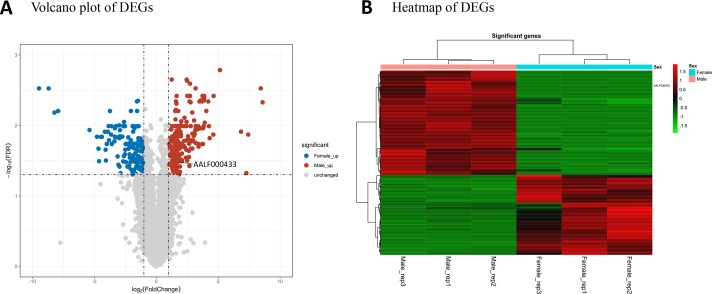
mRNA expression profiles of male and female Ae. albopictus adults. (A) Volcano plot analysis of gene expression variation. Red and blue points correspond to 2.0-fold changes in male and female high-expression mRNAs, respectively, and indicate FDR  < 0.05. (B) Hierarchical clustering of the 305 DEGs in the six samples. Green represents low expression levels and red represents high expression levels.